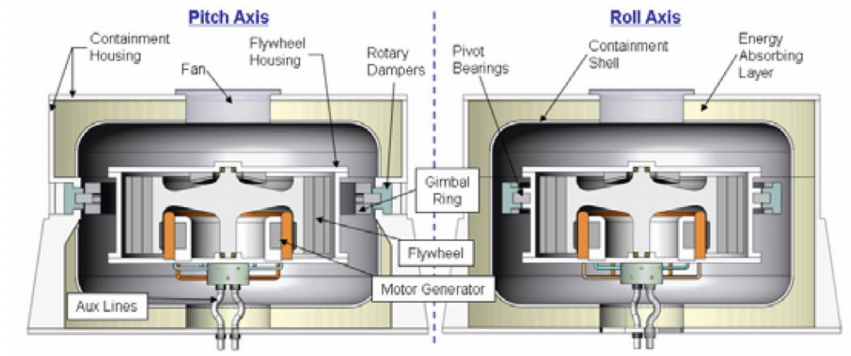
Figure 13. Flywheel containment structure, adapted from